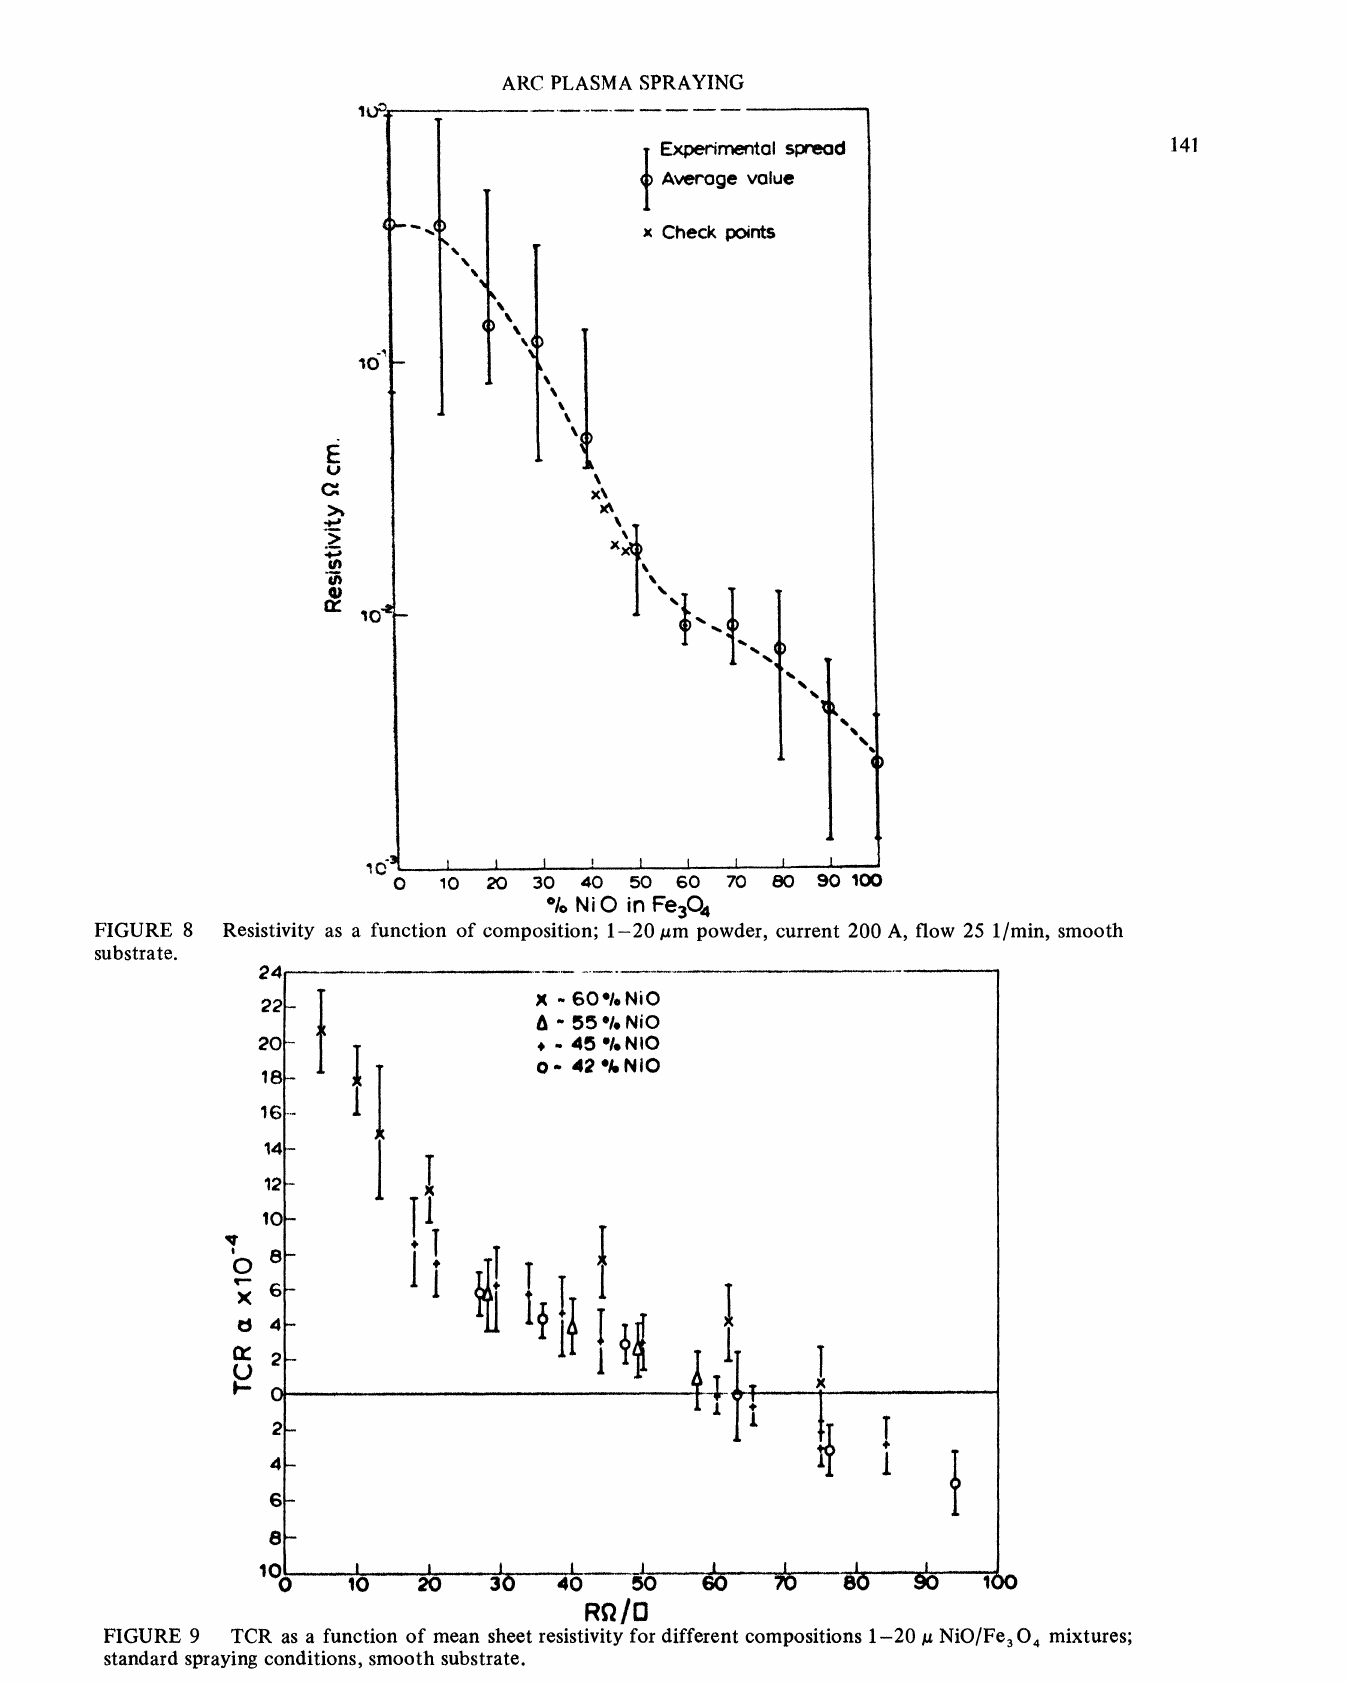
FIGURE 9 TCR as a function of mean sheet resistivity for different compositions 1-20 # NiO/Fe O4 mixtures; standard spraying conditions, smooth